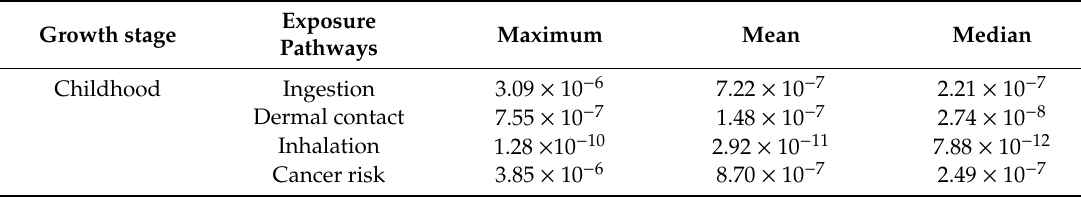
Table 5. Cancer risk potential values due to ingestion, dermal contact, and inhalation of DDTs and HCHs in suburban soils of Nyeri, Kapsabet, and Voi